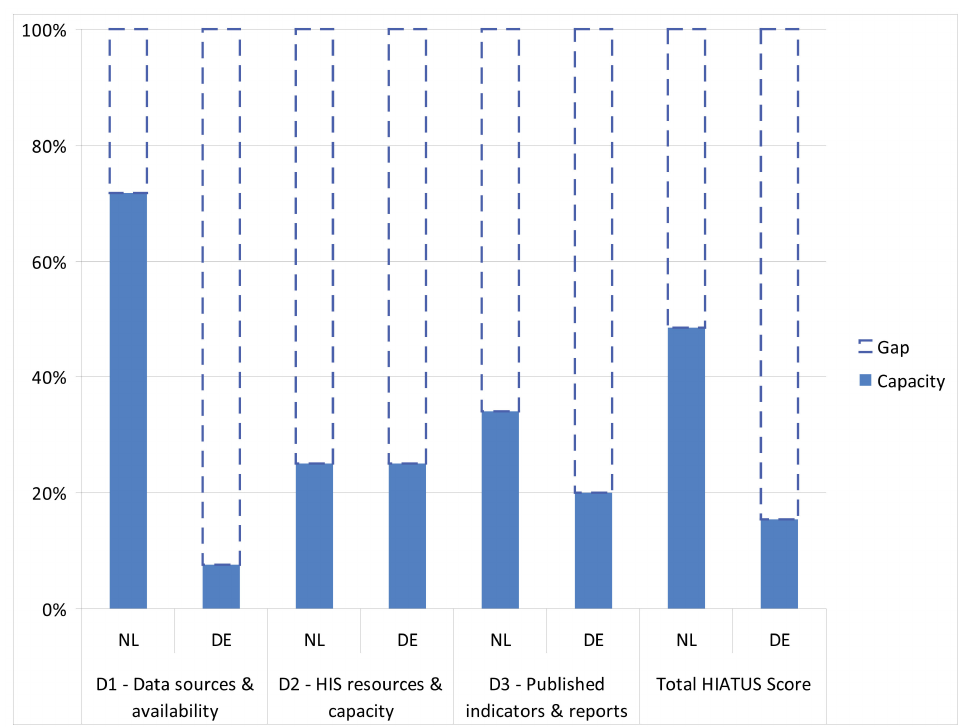
Figure 1. HIS performance as measured by HIATUS, by country and dimension. Y-Axis: Percentage of total HIATUS scores achieved (capacity) and relative within-country difference to maximum achievable score (gap). Table 3. HIS performance by country and between country difference in performance. The Netherlands (NL) Germany (DE) Between-Country Gap within Country Gap within Country Gap Maximum Achieved Abs. Dimensions Achievable Score Score